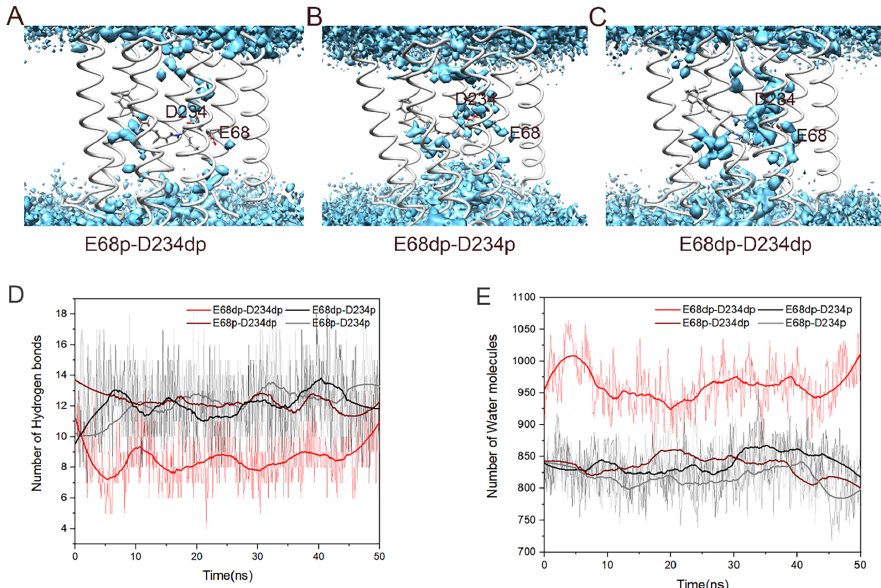
Figure 6. Water density distribution in different protonation states of E68 and D234. ( A ) E68p-D234p, ( B ) E68dp-D234p, and ( C ) E68dp-D234dp. ( D ) The number of hydrogen bonds and ( E ) the number of water molecules in the channel. The last 50 ns equilibrium trajectories were picked for hydrogen bond and water molecule statistics.